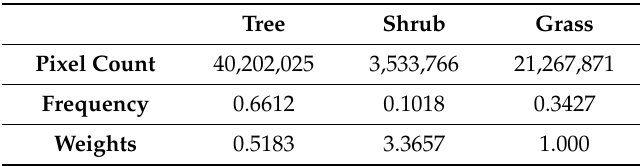
Table 17. Pixel numbers for the three classes, class frequency and median frequency class weights used in DeepLabV3 + training (Oregon—3